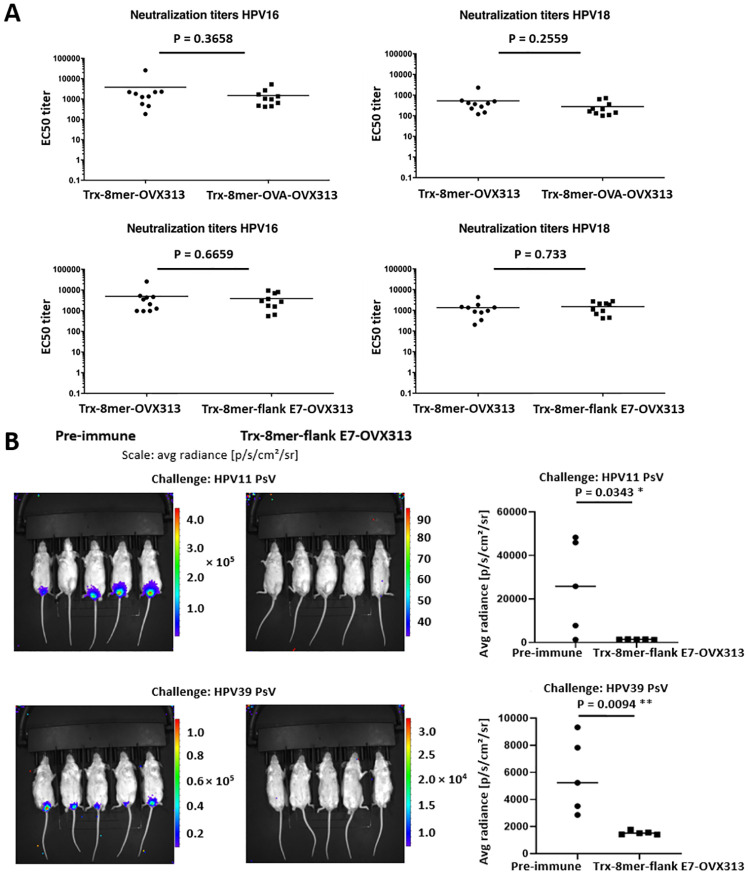
The antigen Trx-8mer-flank E7-OVX313 induces robust humoral immune responses.(A) The presence of the OVA- or flank E7-specific epitopes does not compromise the induction of L2-specific B-cell responses. Sera collected from mice (10 animals/ group) one month after the last immunization with Trx-8mer-OVX313, Trx-8mer-OVA-OVX313 or Trx-8mer-flank E7-OVX313, were analyzed against HPV16 and HPV18 pseudovirions using the L1-PBNA. Each symbol represents the neutralization titer (EC50) of an individual mouse; geometric means of the titers for each group are indicated by the horizontal lines. (B) In vivo protection afforded by anti-Trx-8mer-flank E7-OVX313 sera. Sera from nonimmunized animals were used as control. Sera from 10 mice immunized with the Trx-8mer-flank E7-OVX313 antigen were pooled and passively transferred into naive mice. Recipient animals were then challenged with HPV11 and HPV39 PsVs. Images of in vivo challenge show the magnitude of vaginal infection by HPV11 and 39 PsVs. The color scales indicate the intensity of luciferase expression; a region-of-interest (ROI) analysis for average radiance (photons per second per square centimeter per steradian) was performed using the Living Image 2.50.1 software. Note that due to the different in vivo transduction activities of the various HPV PsV types, different scales were used. The diagrams on the right show the analytical data obtained from the experiments. Each symbol represents the average radiance of an individual mouse with the horizontal lines indicating the geometric means. P-value ≤ 0.05 was considered as significant. *, P-value < 0.05; **, P-value < 0.01.